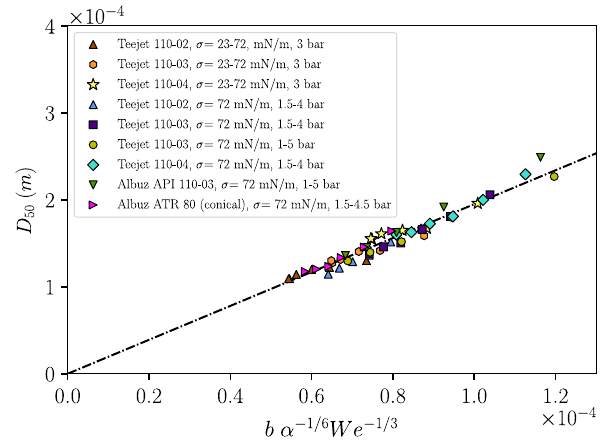
FIG. 6. The median droplet size, D 50 , plotted as indicated in Eq. (9) for all nozzles and various pressures and surface tensions. The slope C is approximately 1.95.